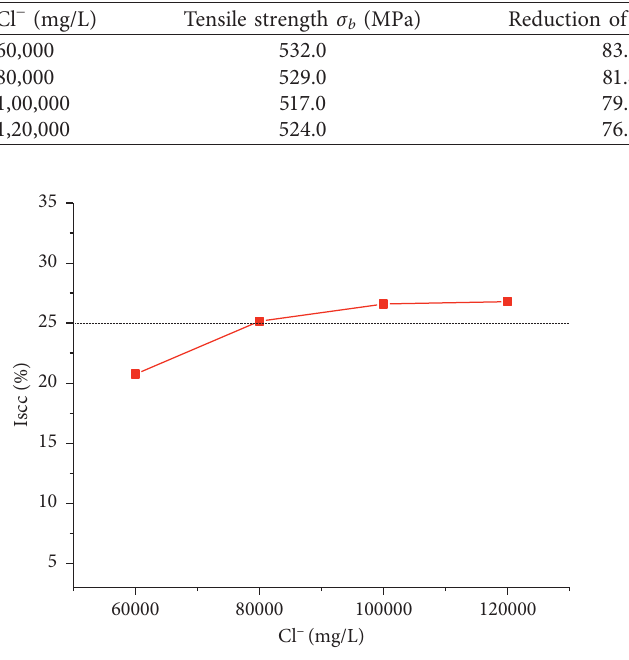
Figure 11: Sensitivity index of stress corrosion cracking of 316L stainless steel at different Cl −